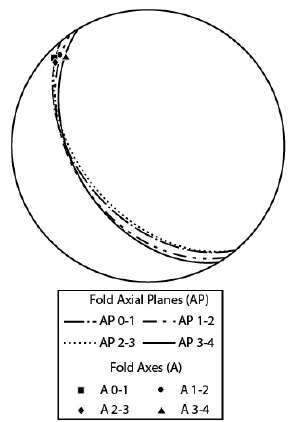
Figure 10. Lower hemisphere stereographic projections of fold axial planes (AP) and fold axes (A). Folds are indicated by the connected limbs (e.g., Fold 0-1 means fold forms by limbs 0 and 1). Attitude data are shown in Table 8. Table 8. Calculated attitudes of Axes (A) and Axial Planes (AP) and interlimb angles of the examined folds.